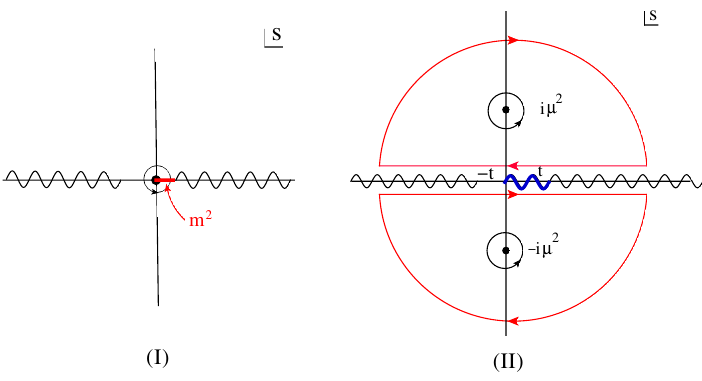
Figure 20 . In the presence of massless cuts, we can either (I) introduce a small mass regulator and push the cut slightly away from the origin, or (II) we analytically define our generalized couplings by moving the contour at origin onto to the complex plane to s = ± iµ in a way that the integration measure is positive definite. After deformation the contour picks up the discontinuity on the real s -axes, which for | t | < | s | , is controlled by unitarity. We can analytically continue to | s | < | t | for theories with well behaved soft